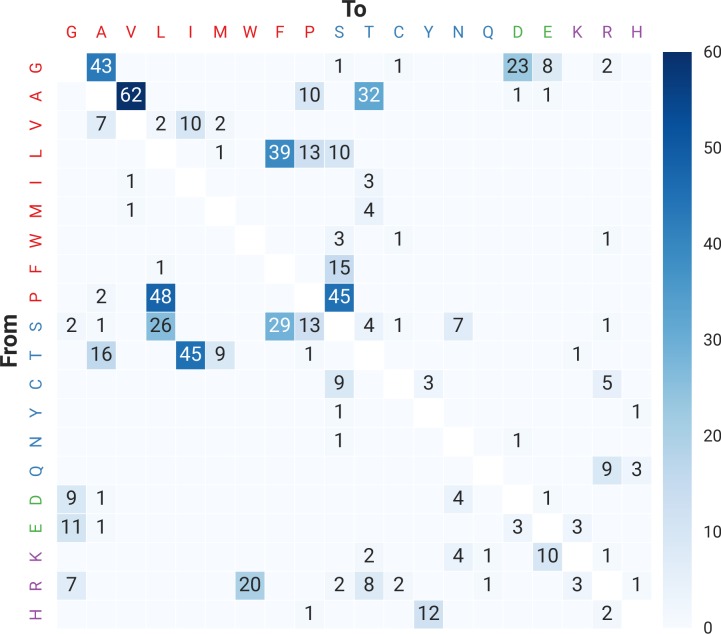
Heatmap of non-synonymous amino acid changes of differentially edited genes.Original amino acid is on the y-axis, while the post-editing amino acid is on the x-axis. Amino acids are represented as single-letter codes, and coloured according to the property of their side chains: non-polar (red), polar uncharged (blue), acidic (green) and basic (purple).